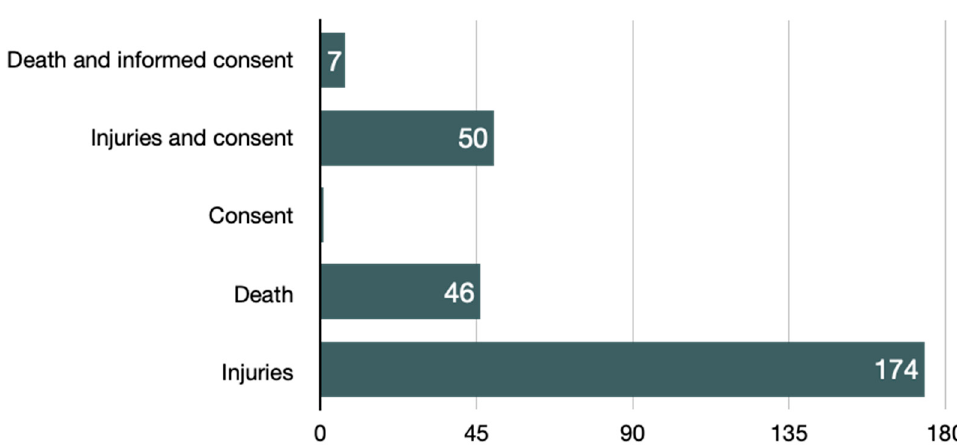
Figure 2. Categories of damages claimed by patients in court.